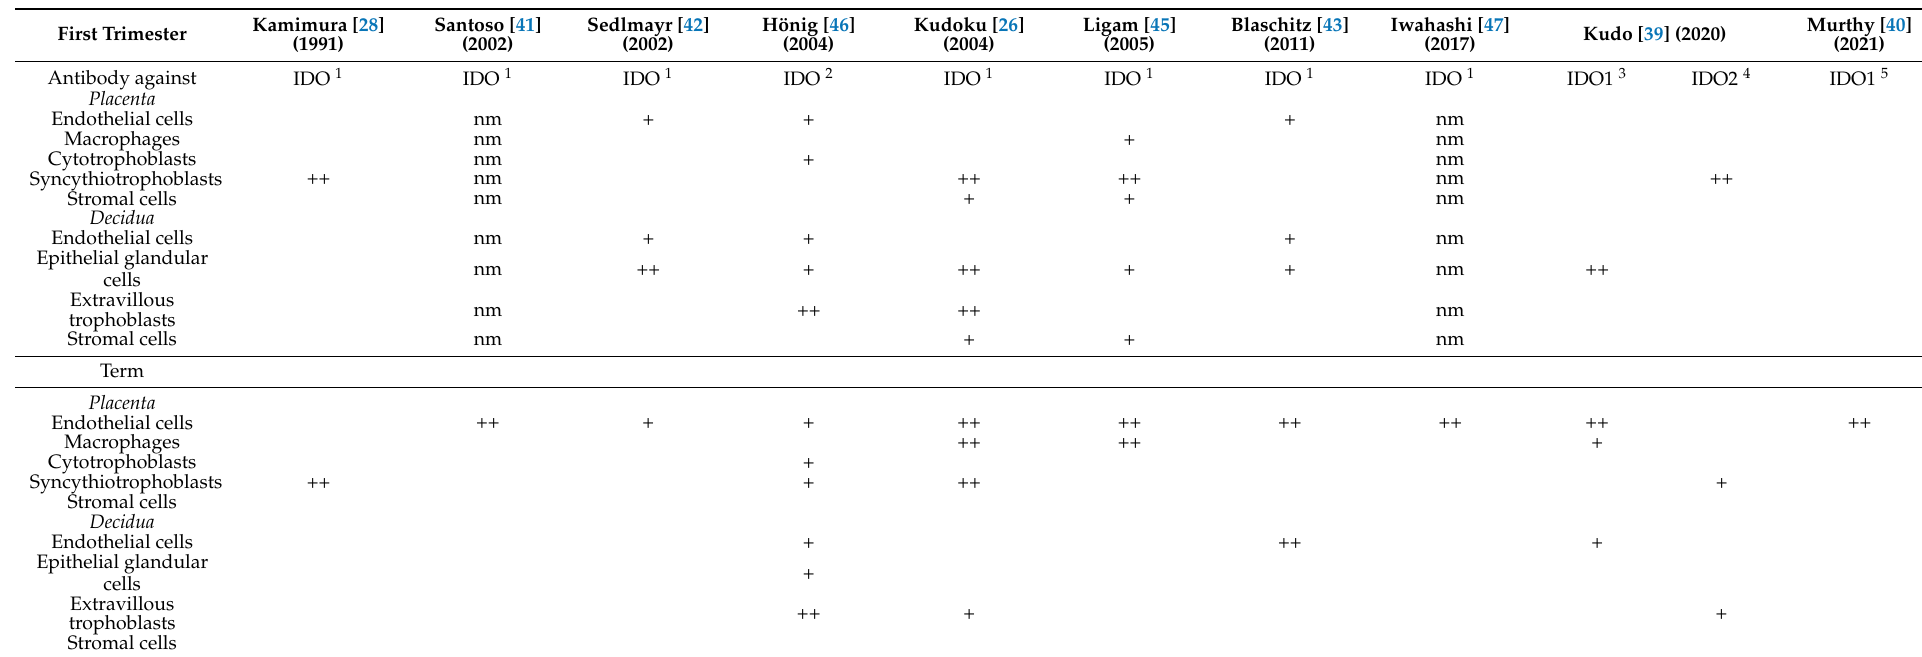
Table 2. Summary of immunohistochemistry studies on placental indoleamine 2,3-dioxygenase (IDO)